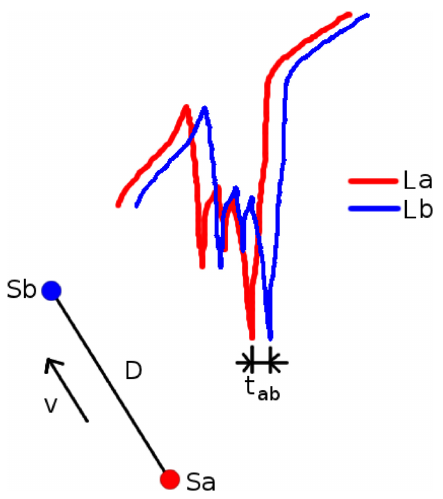
Figure 1. Idealized sketch showing the most correlated pair of sig- nals shifted by t ab (adapted from Bosch et al., 2013).